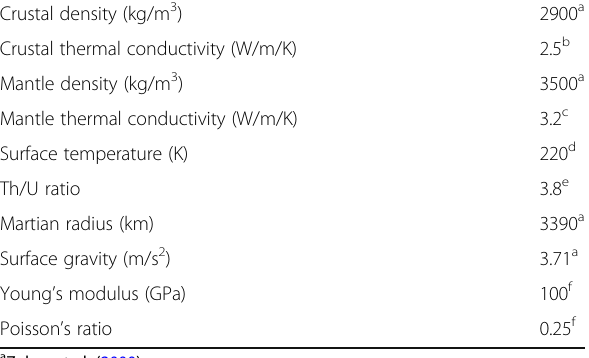
Table 1 Physical and thermal parameters used in